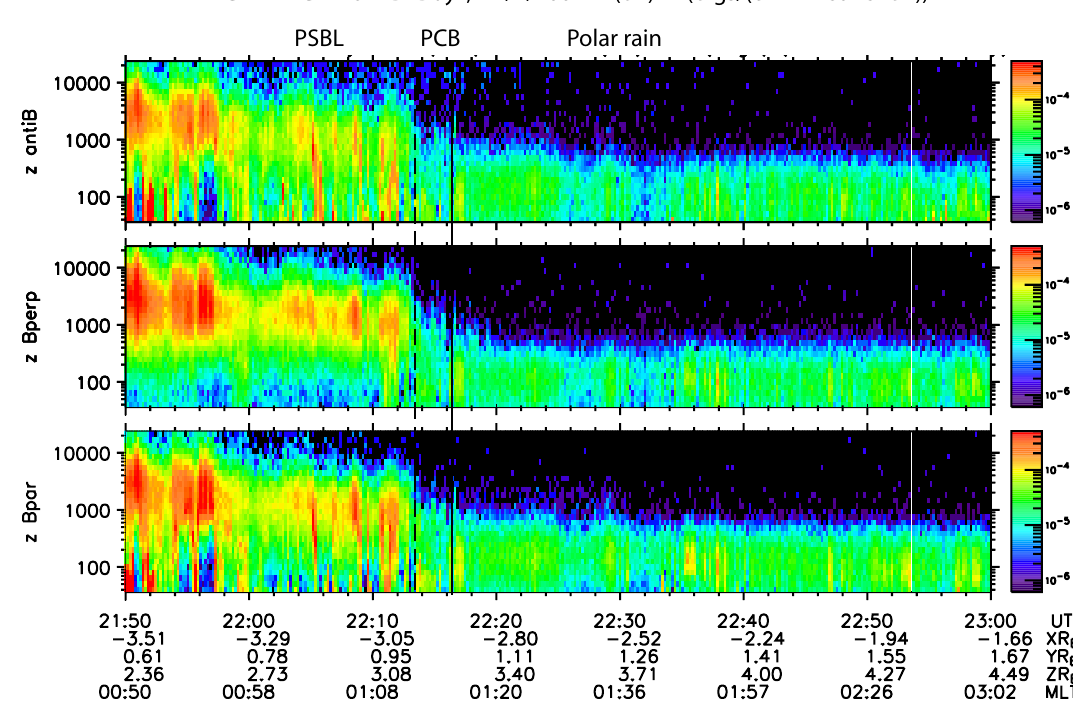
Fig. 6. PEACE measurement on C1 of electron energy fluxes in units of erg cm − 2 sr − 1 s − 1 eV − 1 in the upward (top), perpendicular (middle) and downward (bottom) directions. The PSBL and Polar rain regions are shown.